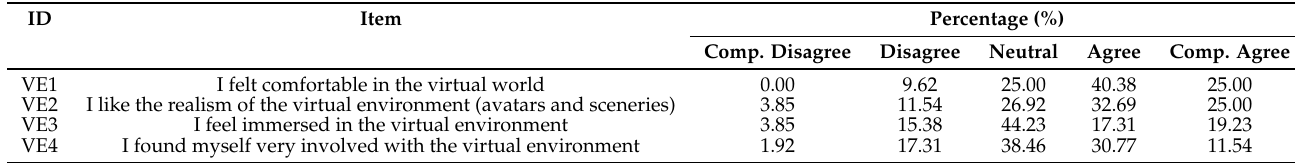
Table 6. Numerical results for ‘Virtual